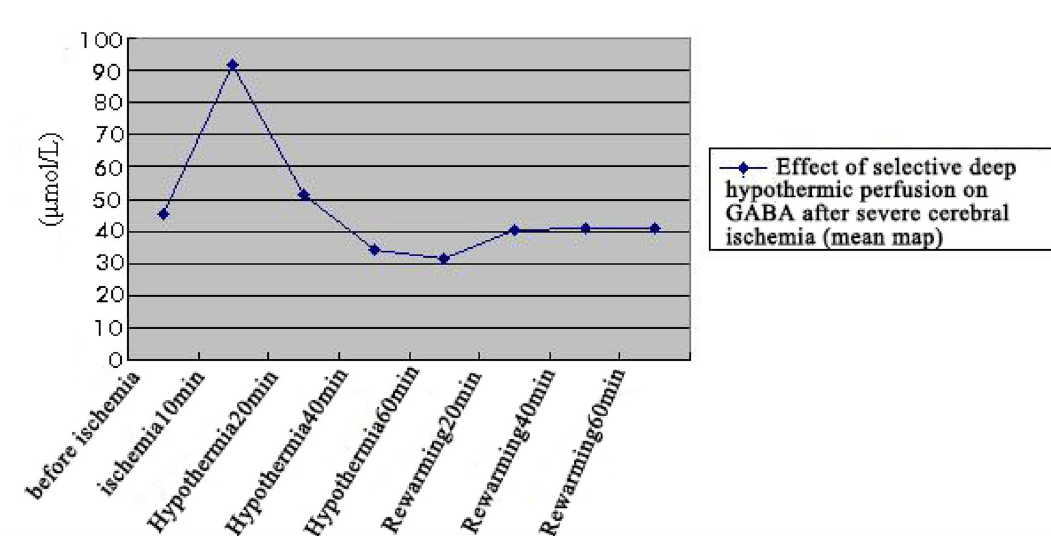
Figure 17. Changes of GABA content in brain extracellular fluid.